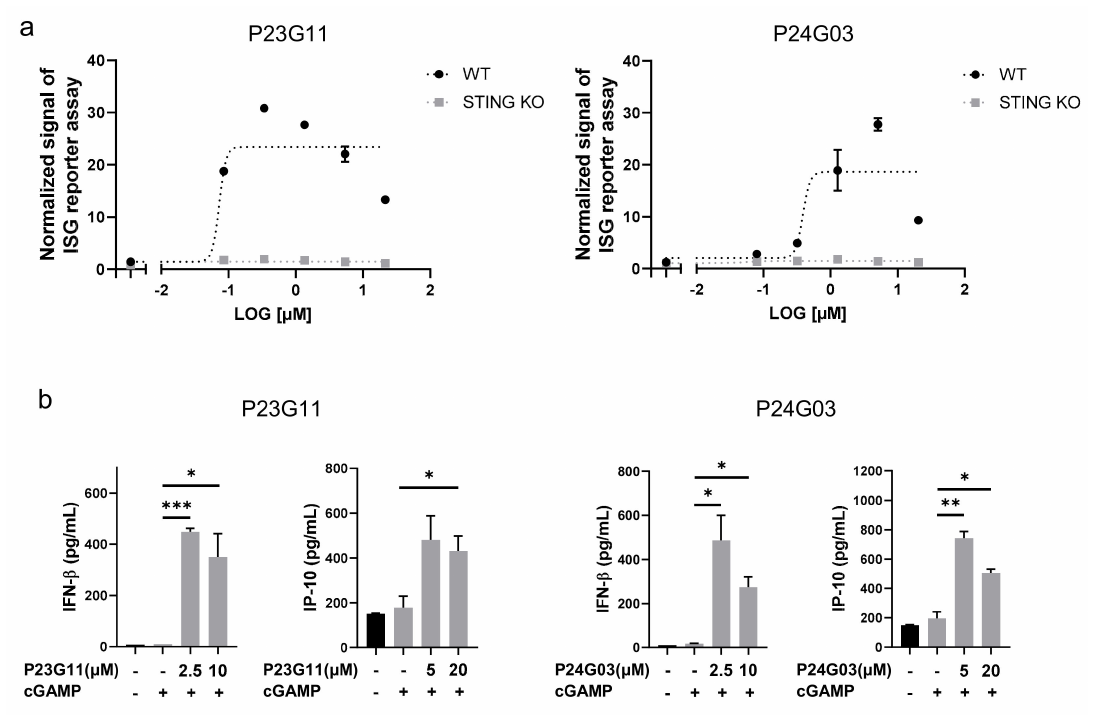
Figure 1. Identification of small-molecule STING activators via phenotypic screening. ( a ) ISG reporter assay of P23G11 and P24G03 in presence of cGAMP (1 µ g/mL) in THP-1 WT and STING KO cells. Luciferase signal was normalized by DMSO control. ( b ) Measurement of IFN- β and IP-10 secretion by ELISA. Compounds were treated in THP-1 cells for 24 h using the indicated concentration. Graphs show the mean and standard deviation (SD). *: p < 0.05, **: p < 0.01, and ***: p < 0.001 by Student’s t -test.